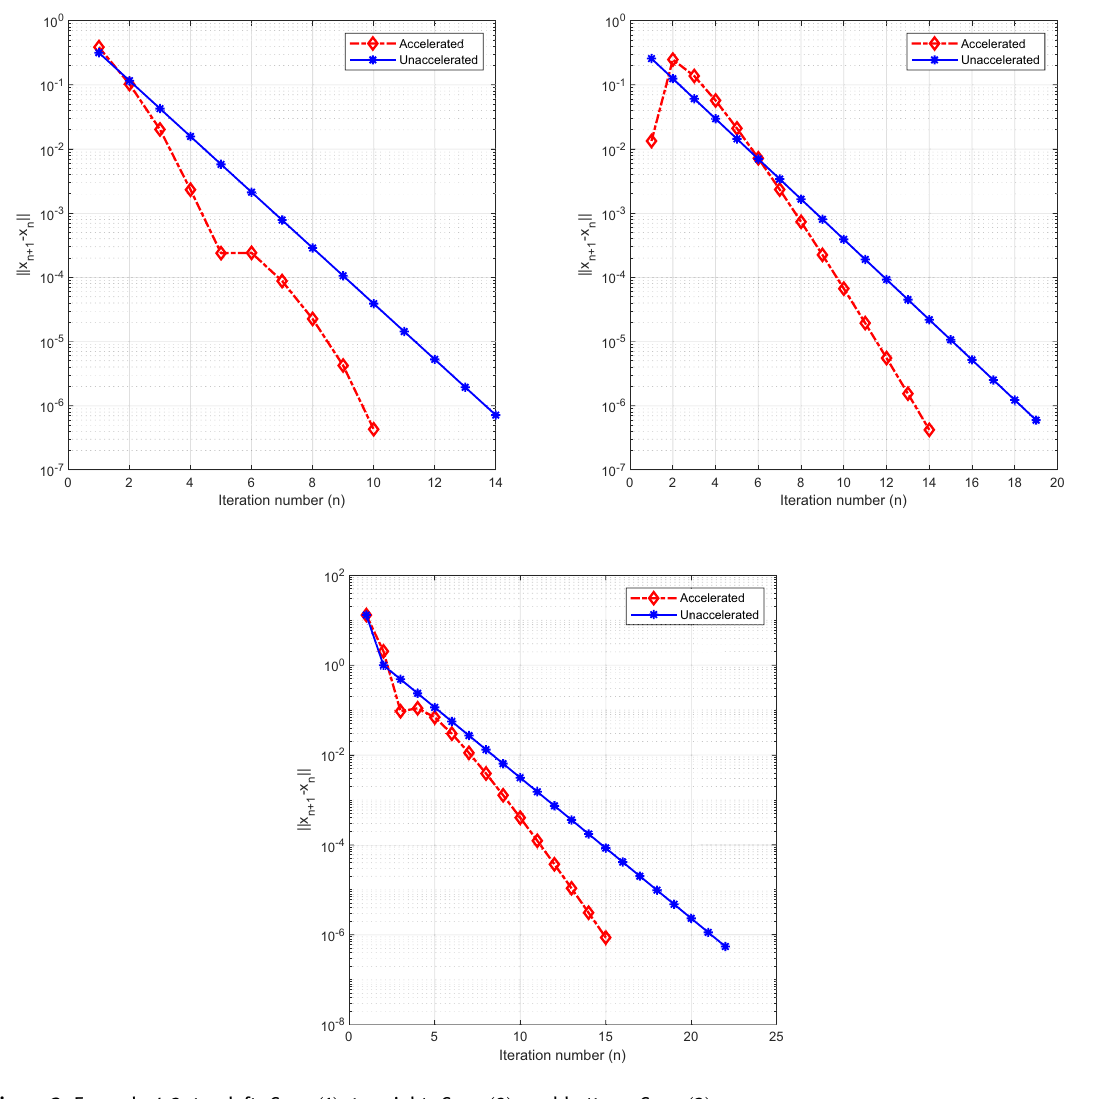
Figure 3: Example 4.3, top left: Case ( 1 ) ; top right: Case ( 2 ) ; and bottom: Case ( 3 )